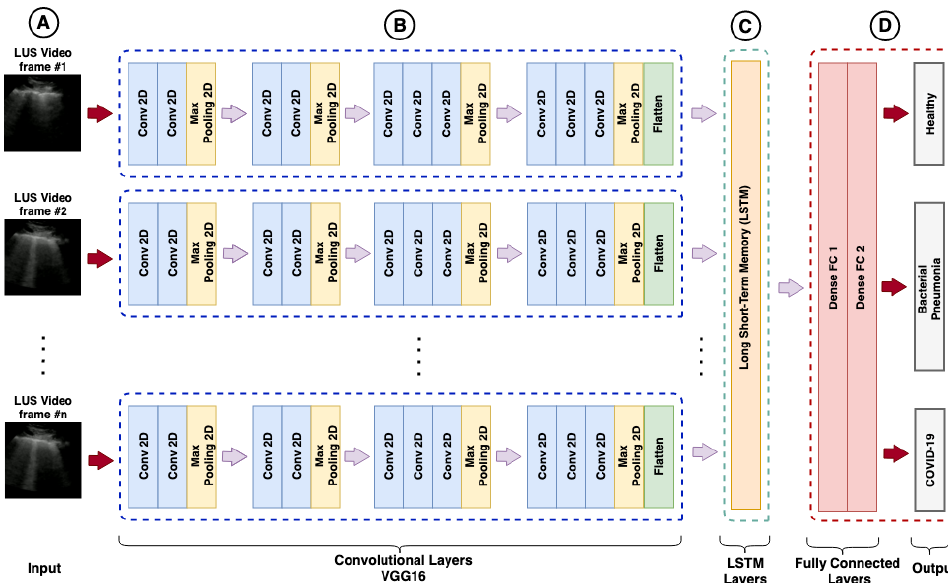
Figure 7. Hybrid model (VGG16-LSTM): Column ( A ) represents the sequence of images extracted from the videos. Group ( B ) represents the convolutional layers based of a VGG16. Group ( C ) represents the long short-term memory (LSTM) layer responsible for learning temporal features. Group ( D ) represents the classification layer.